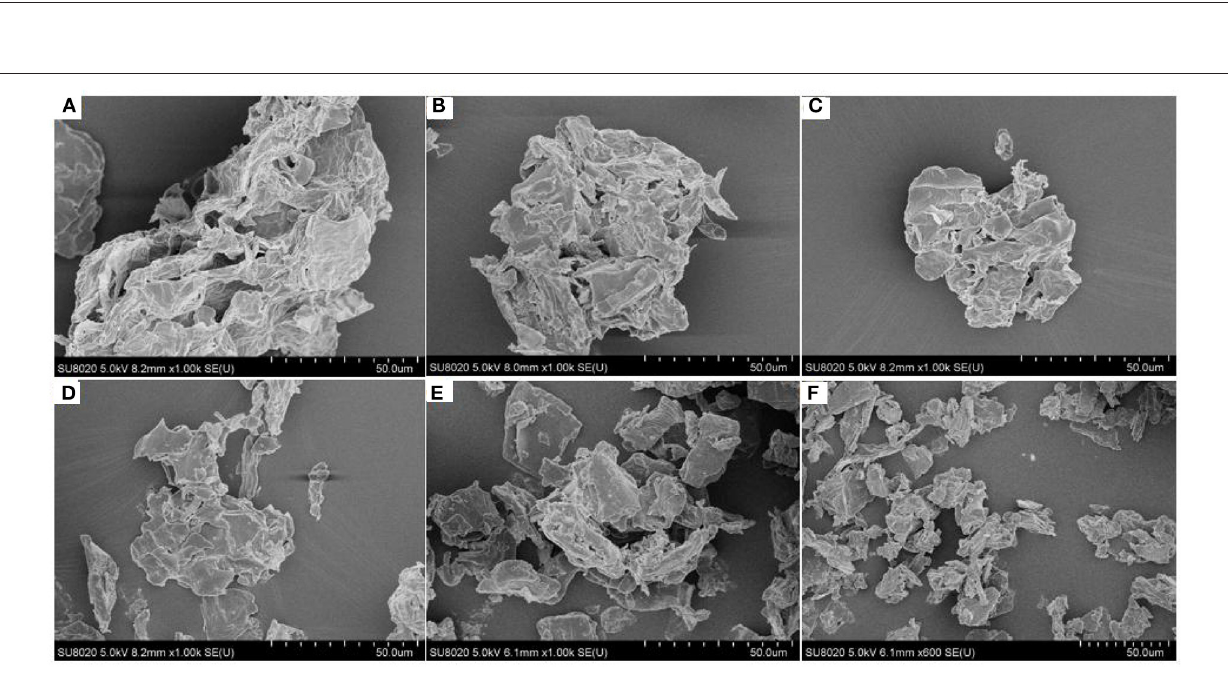
Frontiers in Nutrition |